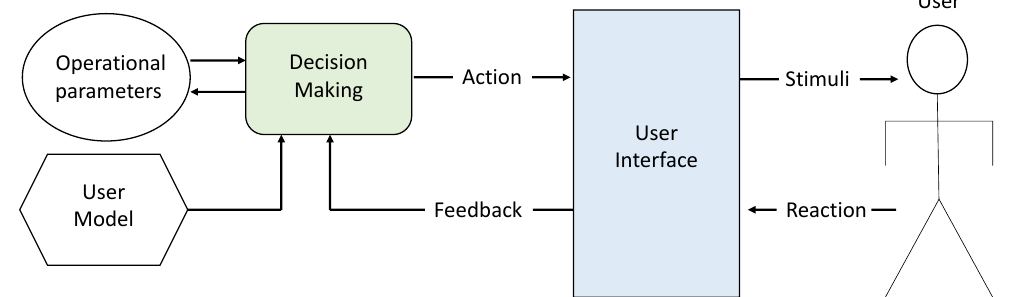
Figure 7. General schematic of a user-adaptive system based on static user models.